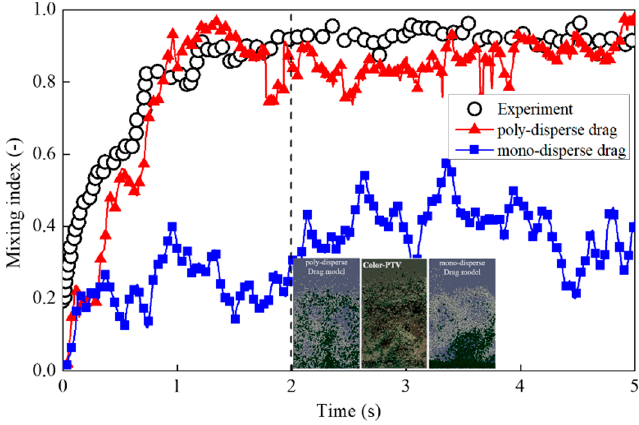
Figure 4. Evolutionary profiles of the mixing index between simulations and experiment.